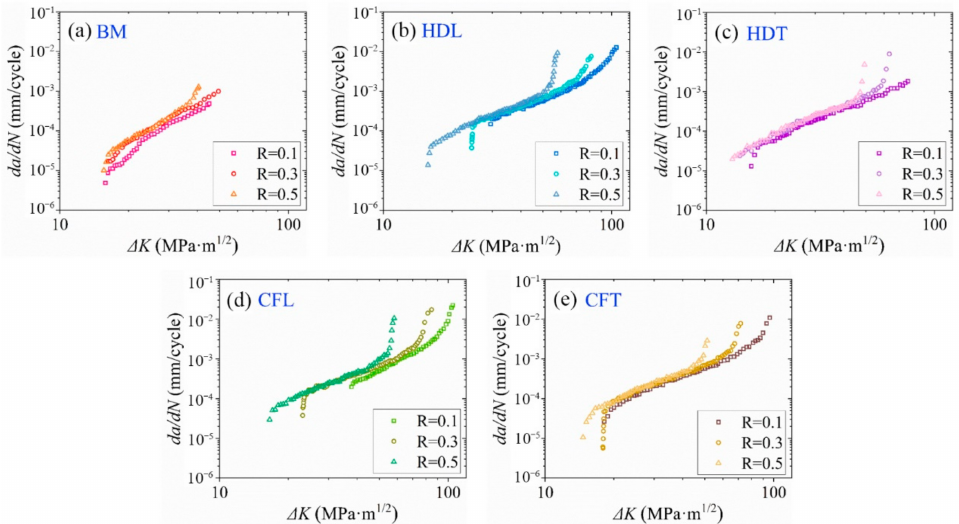
Figure 6. FCG rates of specimens under different stress ratios: ( a ) BM; ( b ) HDL; ( c ) HDT; ( d ) CFL; ( e )